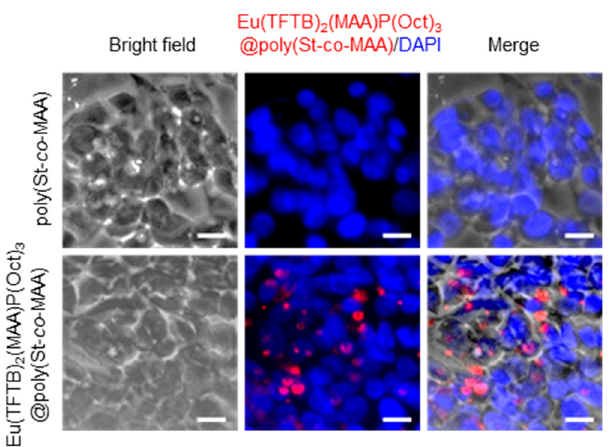
Figure 10. Fluorescence images of intracellular uptake and trafficking of poly(St- co -MAA) and Eu(TFTB) 2 (MAA)P(Oct) 3 @poly(St- co -MAA) in HepG2 cells. Nuclei were stained with DAPI (blue). Scale bar, 20 μ m.